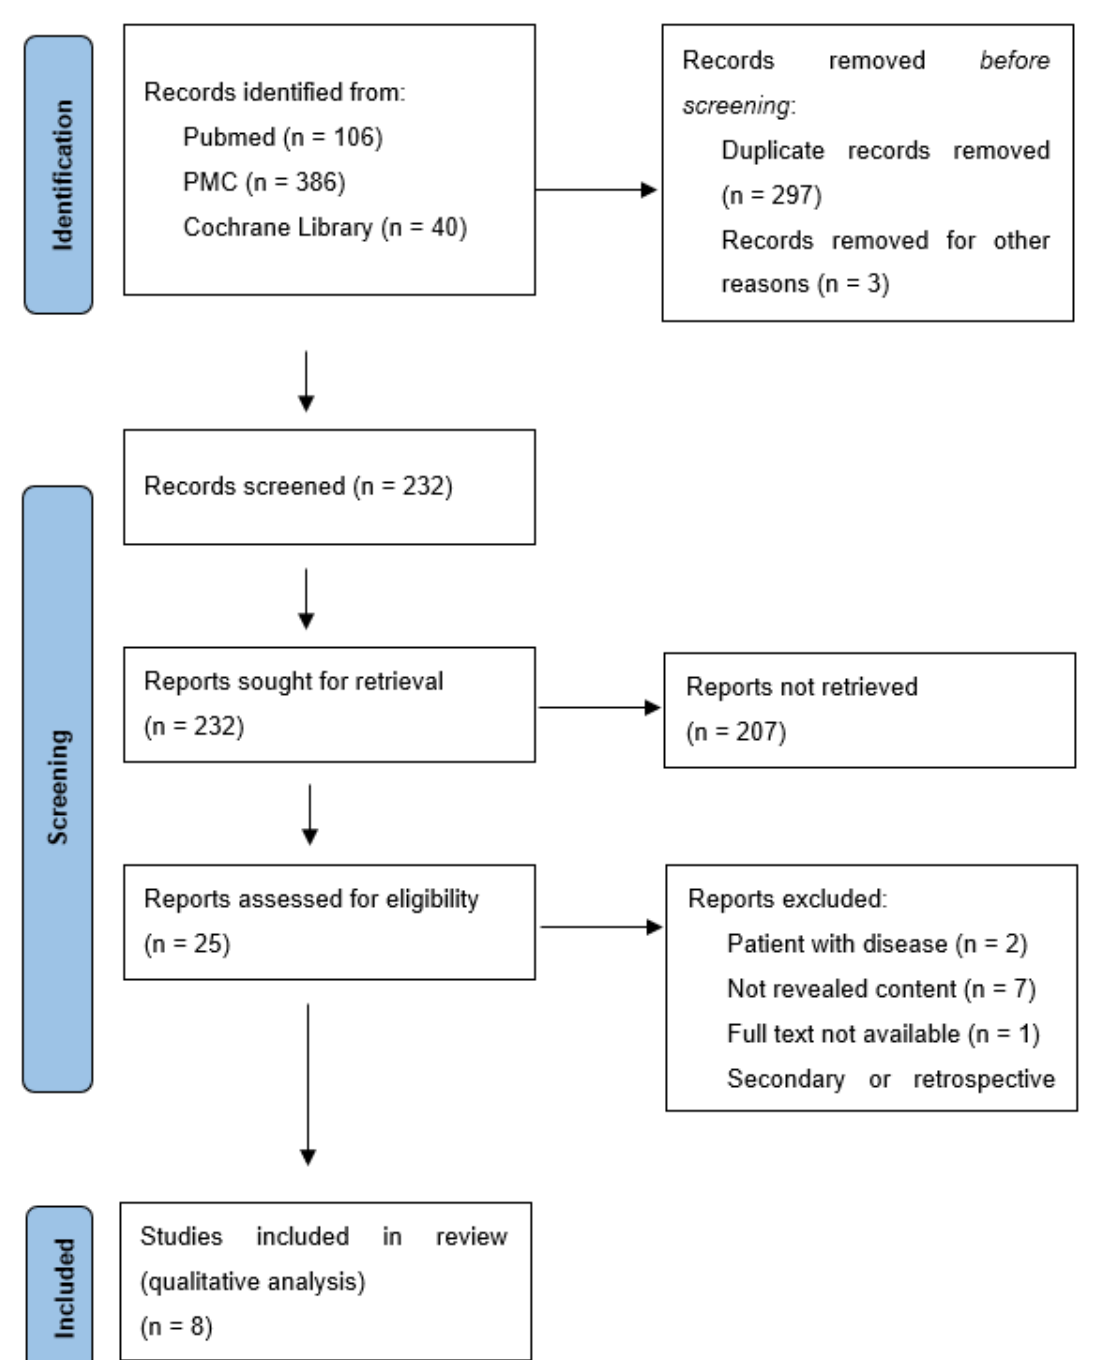
Figure 1. Research PRISMA Flow diagram.